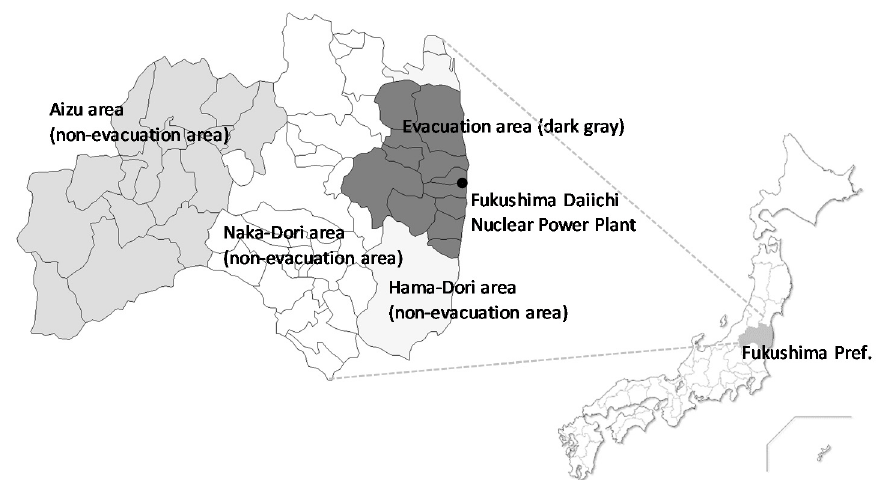
Figure 1. Evacuation and non-evacuation areas in Fukushima. Regions colored in dark gray correspond to the municipalities where evacuation orders were issued. Hama-Dori, Naka-Dori, and Aizu were the non-evacuation areas.